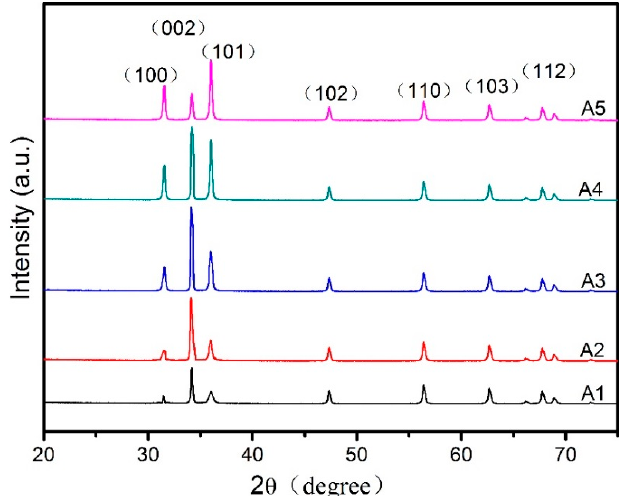
Figure 5. X-ray diffraction spectra of the ZnO thin films for sol concentrations of ( A1 ) 0.2 M, ( A2 ) 0.4 M, ( A3 ) 0.6 M, ( A4 ) 0.8 M, and ( A5 ) 1.0 M. M, ( A3 ) 0.6 M, ( A4 ) 0.8 M, and ( A5 ) 1.0